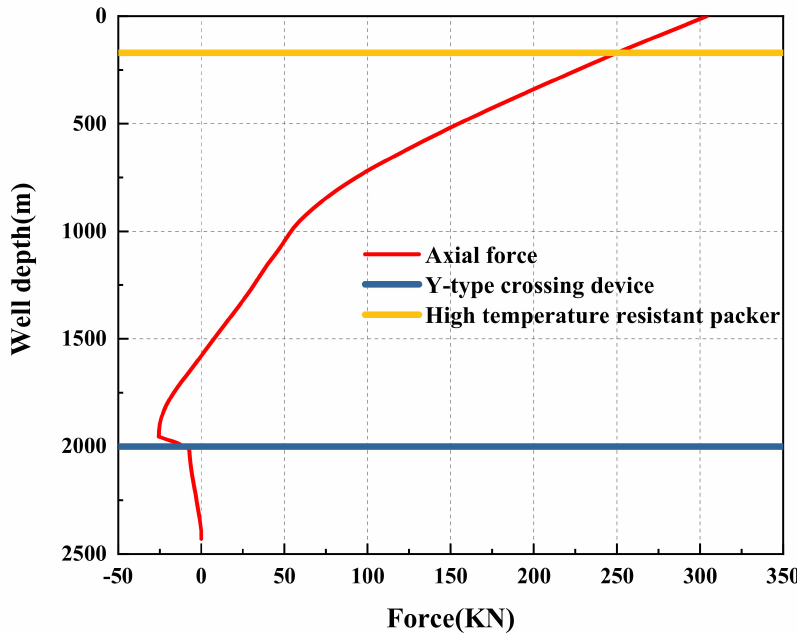
Figure 10. Axial force distribution of integrated injection-production string.